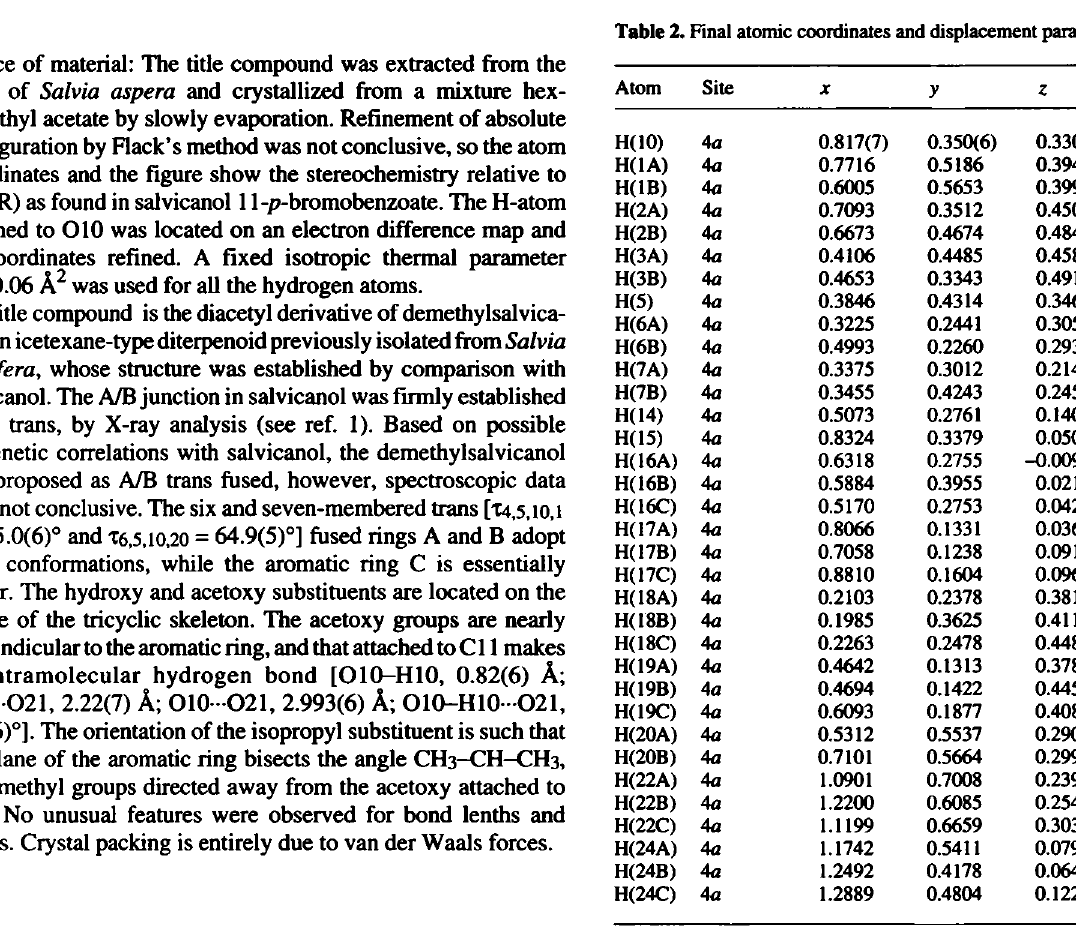
Table 2. Final atomic coordinates and displacement parameters (in